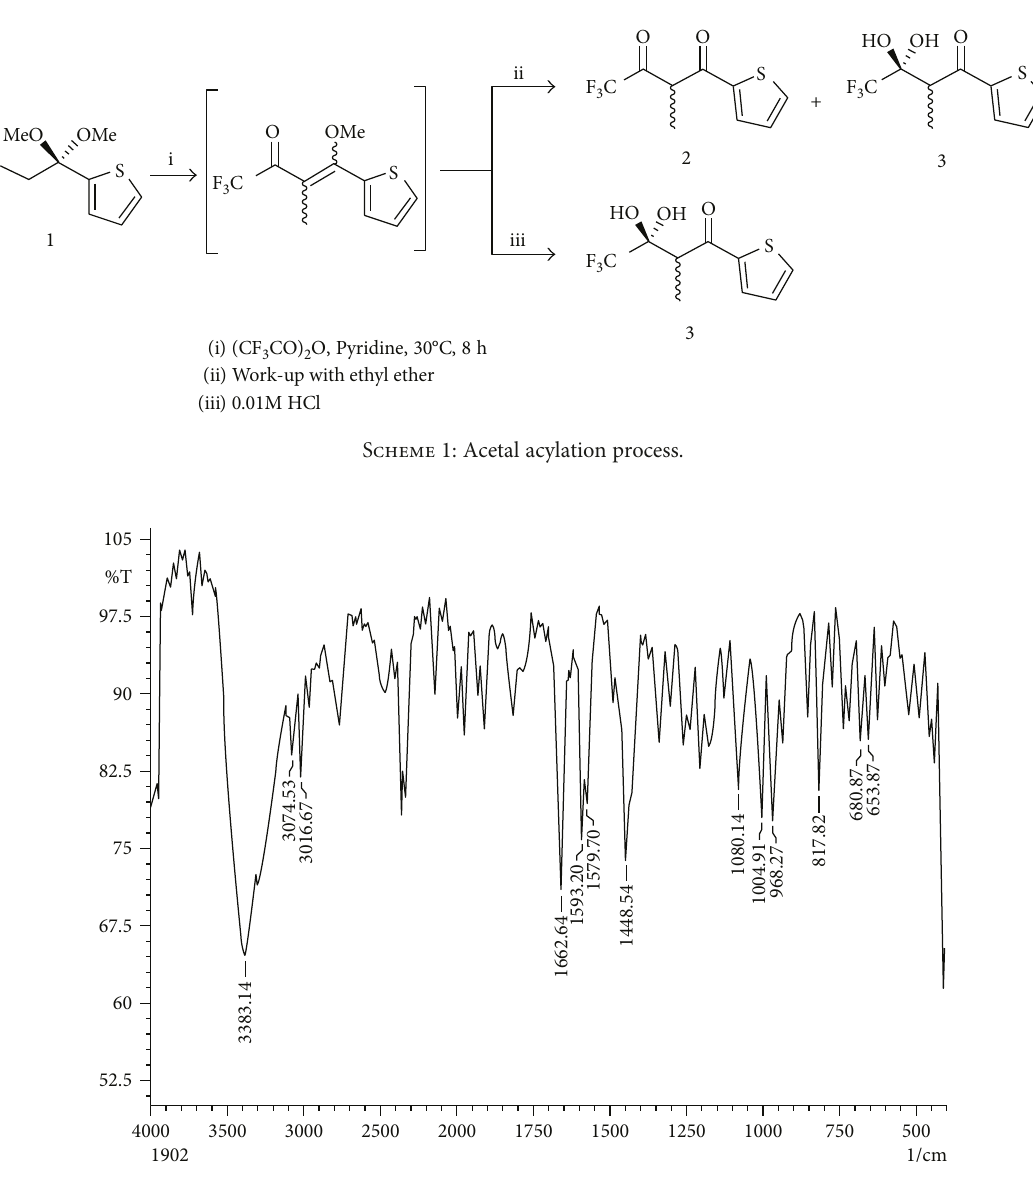
Figure 2: Infrared absorption spectrum of 3,3-dihydroxy-4,4,4-tri fl uoro-2-methyl-1-(2-thien-2-yl)butan-1-one